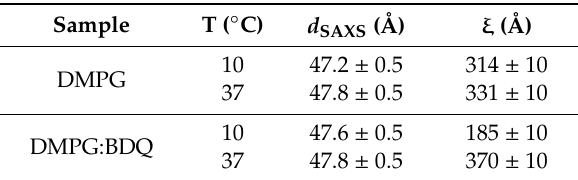
Table 5. SAXS di ff raction profiles of 1,2-dimyristoyl- sn -glycero-3-phospho- rac -(1-glycerol) (DMPG) and DMPG with BDQ at 5% molar ratio at 10 and 37 ◦ C.